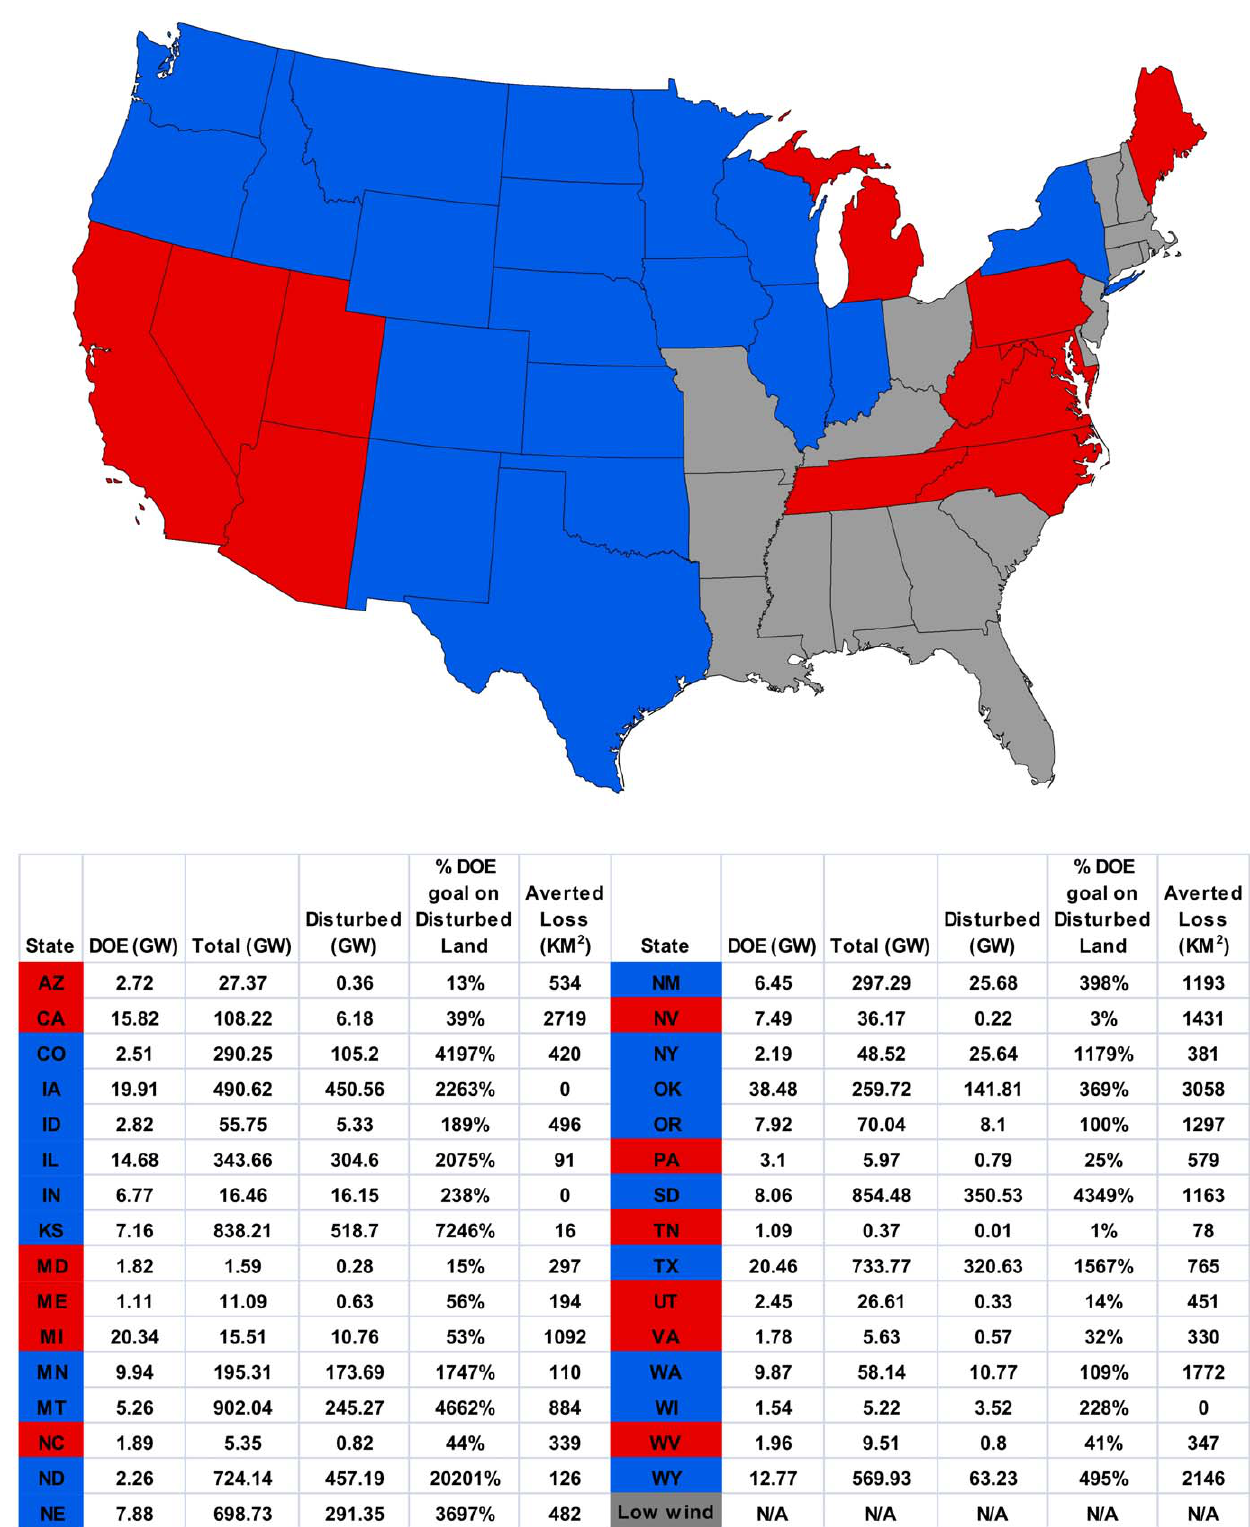
Figure 1. Map of continental U.S. with states where DOE targets can (blue) and cannot (red) be met on disturbed lands. We focused on the 31 states that comprise the majority of the DOE vision, excluding states (grey) with less than 1 GW of projected development [1]. Inset table with 31 focal states, their DOE projections (in GW), Total available wind energy (in GW), wind energy available on disturbed lands (in GW), percent of DOE vision that can be met on disturbed land and amount of undisturbed lands that a disturbance focused development scenario would avert (in square kilometers).